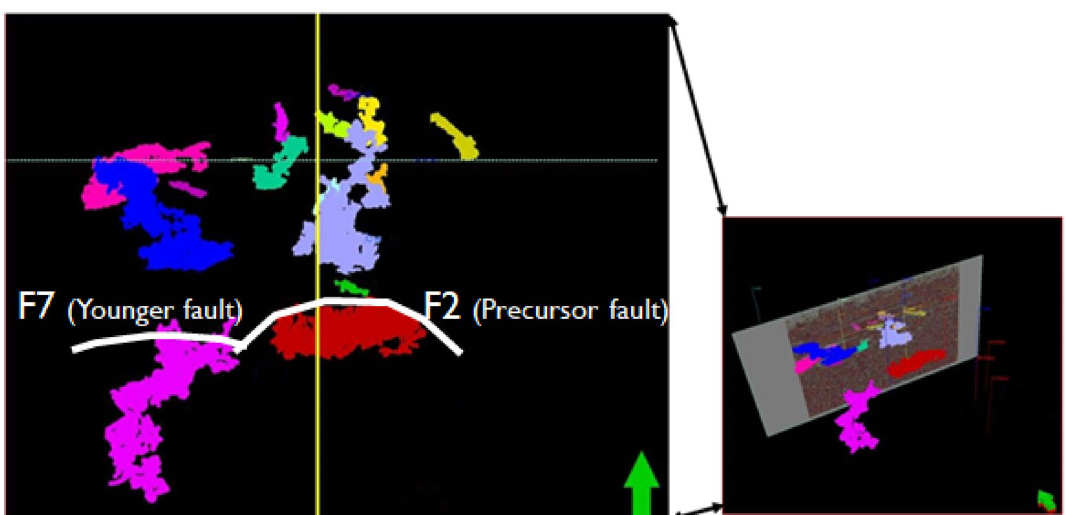
Fig. 10 Geobodies extracted within the study area with co-planar faults overlay